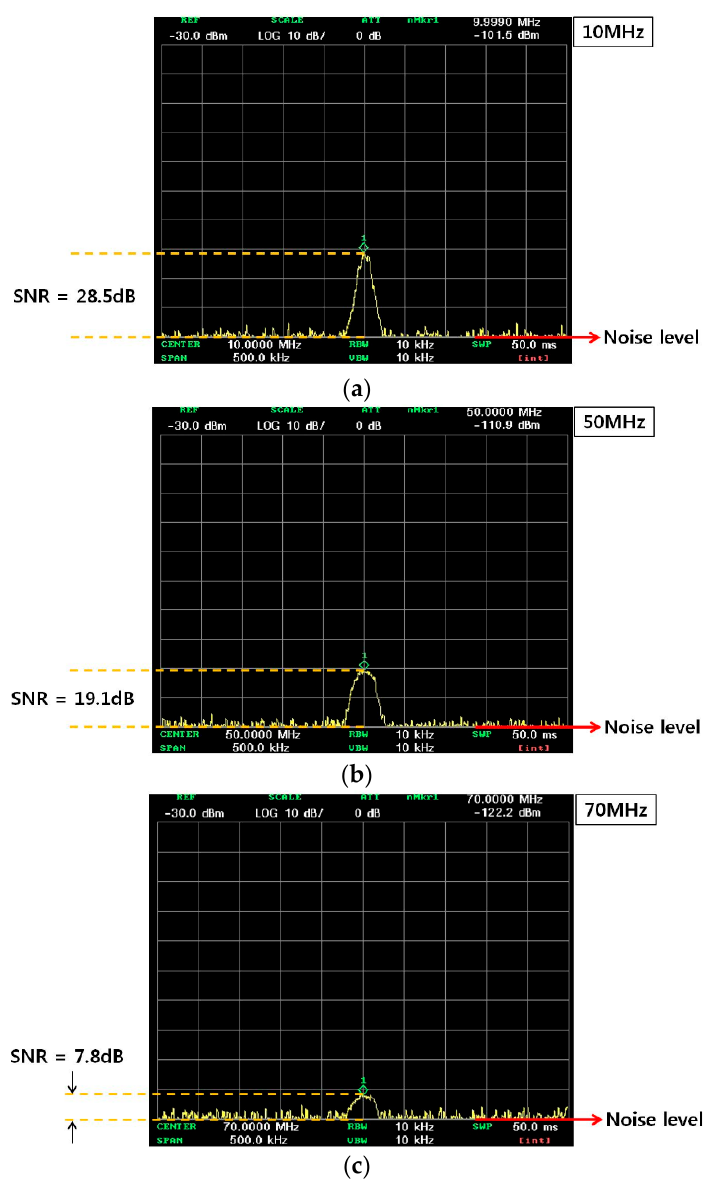
Figure 8. The detected rf spectra of ( a ) 10 MHz, ( b ) 50 MHz, and ( c ) 70 MHz rf input signals into the TEM cell, with a power level of 100 mW.